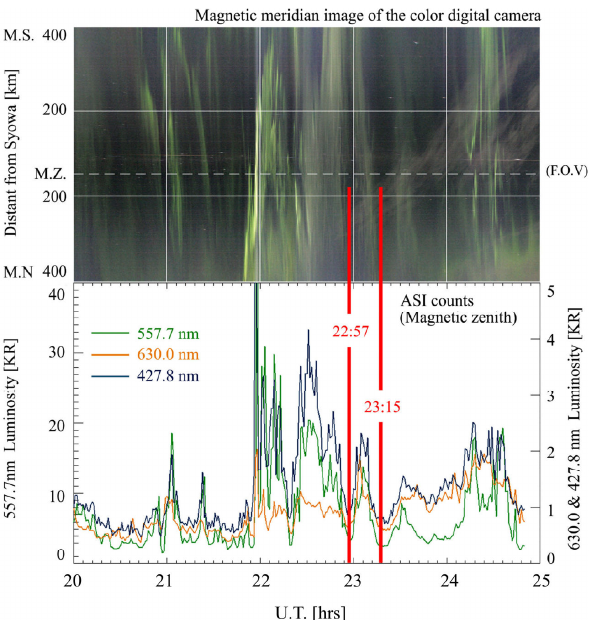
Figure 3. Visible aurora activity on the night of 27/28, March, 2008 observed by CDC 2 Fig. 3. Visible aurora activity on the night of 27/28 March 2008 observed by CDC (upper panel) and ASI (lower panel). M.N. rep- (upper panel) and ASI (lower panel). M.N represents the magnetic north pole, M.S the 3 resents the magnetic north pole, M.S. the magnetic south pole, and magnetic south pole, and M.Z the magnetic zenith. The lines plotted in the lower panel 4 M.Z. the magnetic zenith. The lines plotted in the lower panel are the luminosity of the representative auroral emissions from the mag- are the luminosity of the representative auroral emissions from the magnetic zenith 5 netic zenith observed by the ASI. Note that vertical scales for the intensities at 557.7nm and 630.0 (or 427.8)nm are observed by the ASI. Note that vertical scales for the intensities at 557.7 nm and 630.0 6 (or 427.8) nm are different. 7